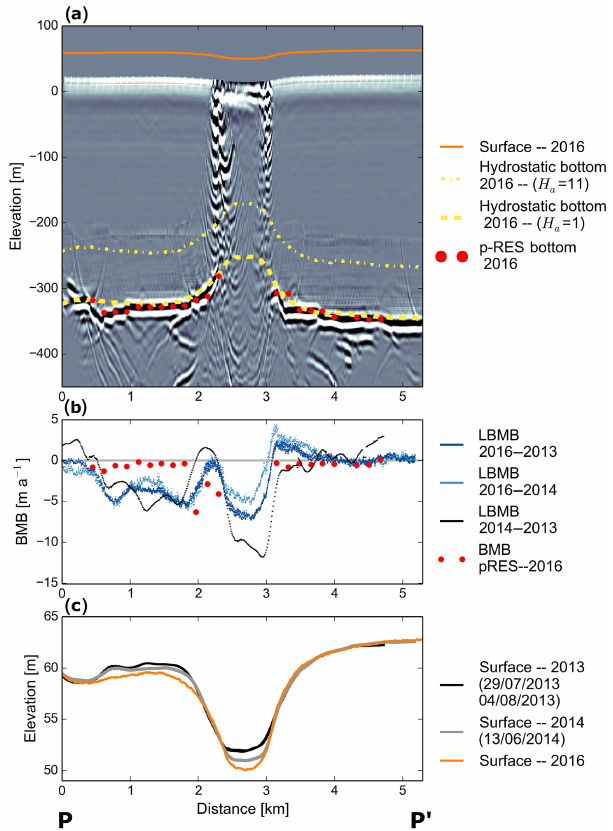
Figure 8. Profile PP (cid:48) across the elliptical surface depression located in Fig. 7. (a) Ice thickness from profiling and phase-sensitive radars together with ice surface and hydrostatically inverted ice bottom from 2016, measured with GNSS. (b) Different time slices of the basal mass balance. Data from 2013 and 2014 are based on the TanDEM-X DEMs, data from 2016 use GNSS surface elevations. (c) Surface lowering at the elliptical depression: surface elevation between the 2016 GNSS profile and the TanDEM-X profiles from 2013 and 2014. Elevations are referenced to the WGS84 ellipsoid and all profiles are shown in Lagrangian